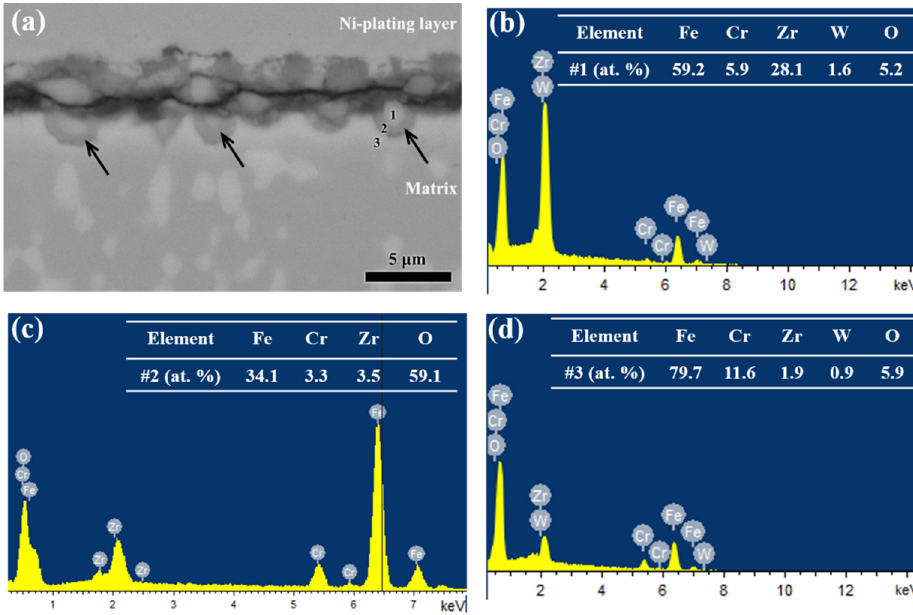
Figure 5. ( a ) BSE images of cross-sectional morphologies of Fe-Cr-Zr alloy after oxidation in air at 923 K for 10 min. ( b – d ) EDS spectrums for point 1, point 2, and point 3 marked in ( a ).